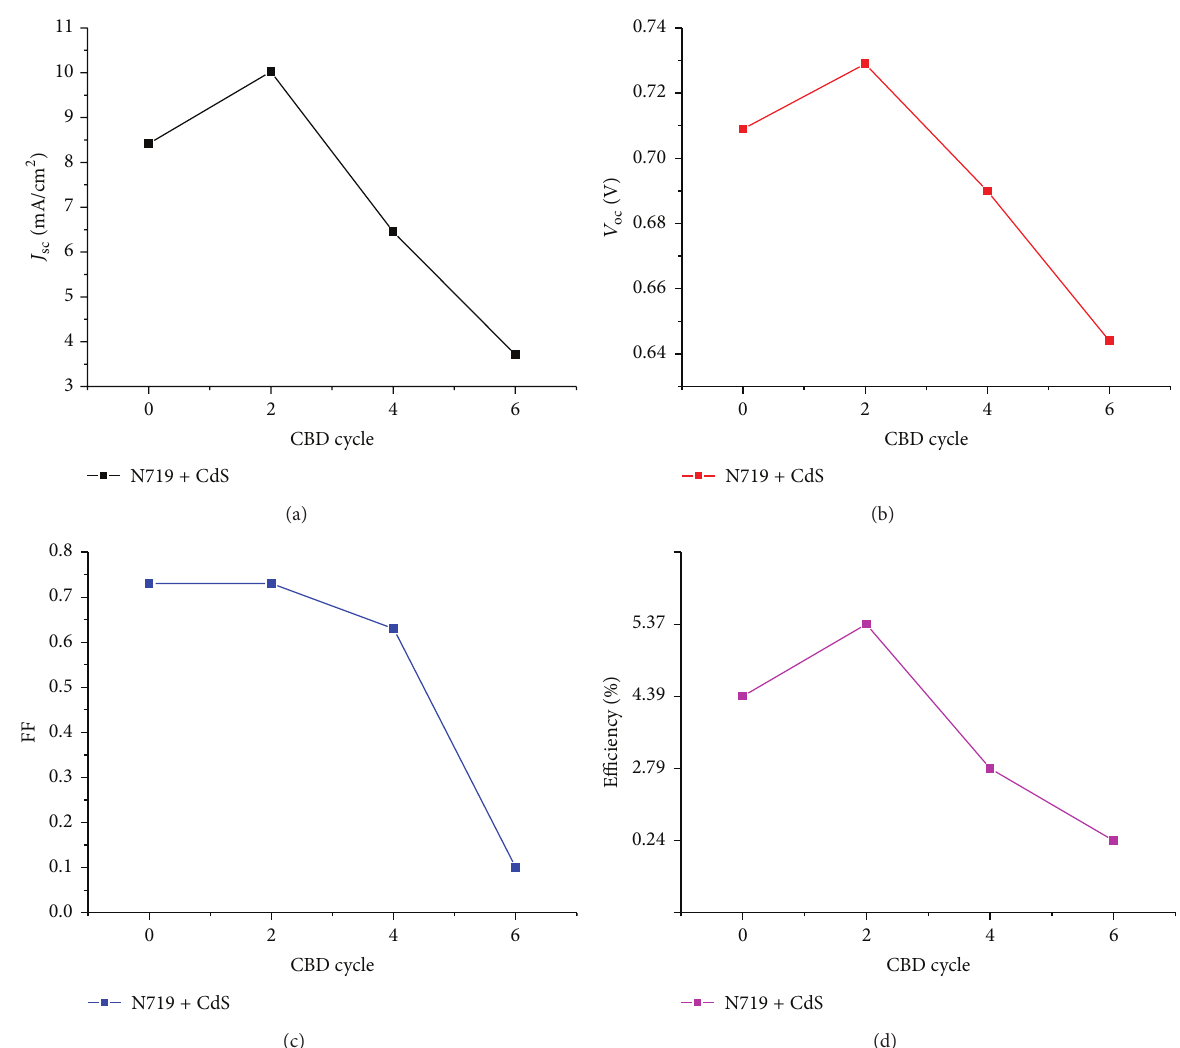
Figure 5: Trend of the 𝐽